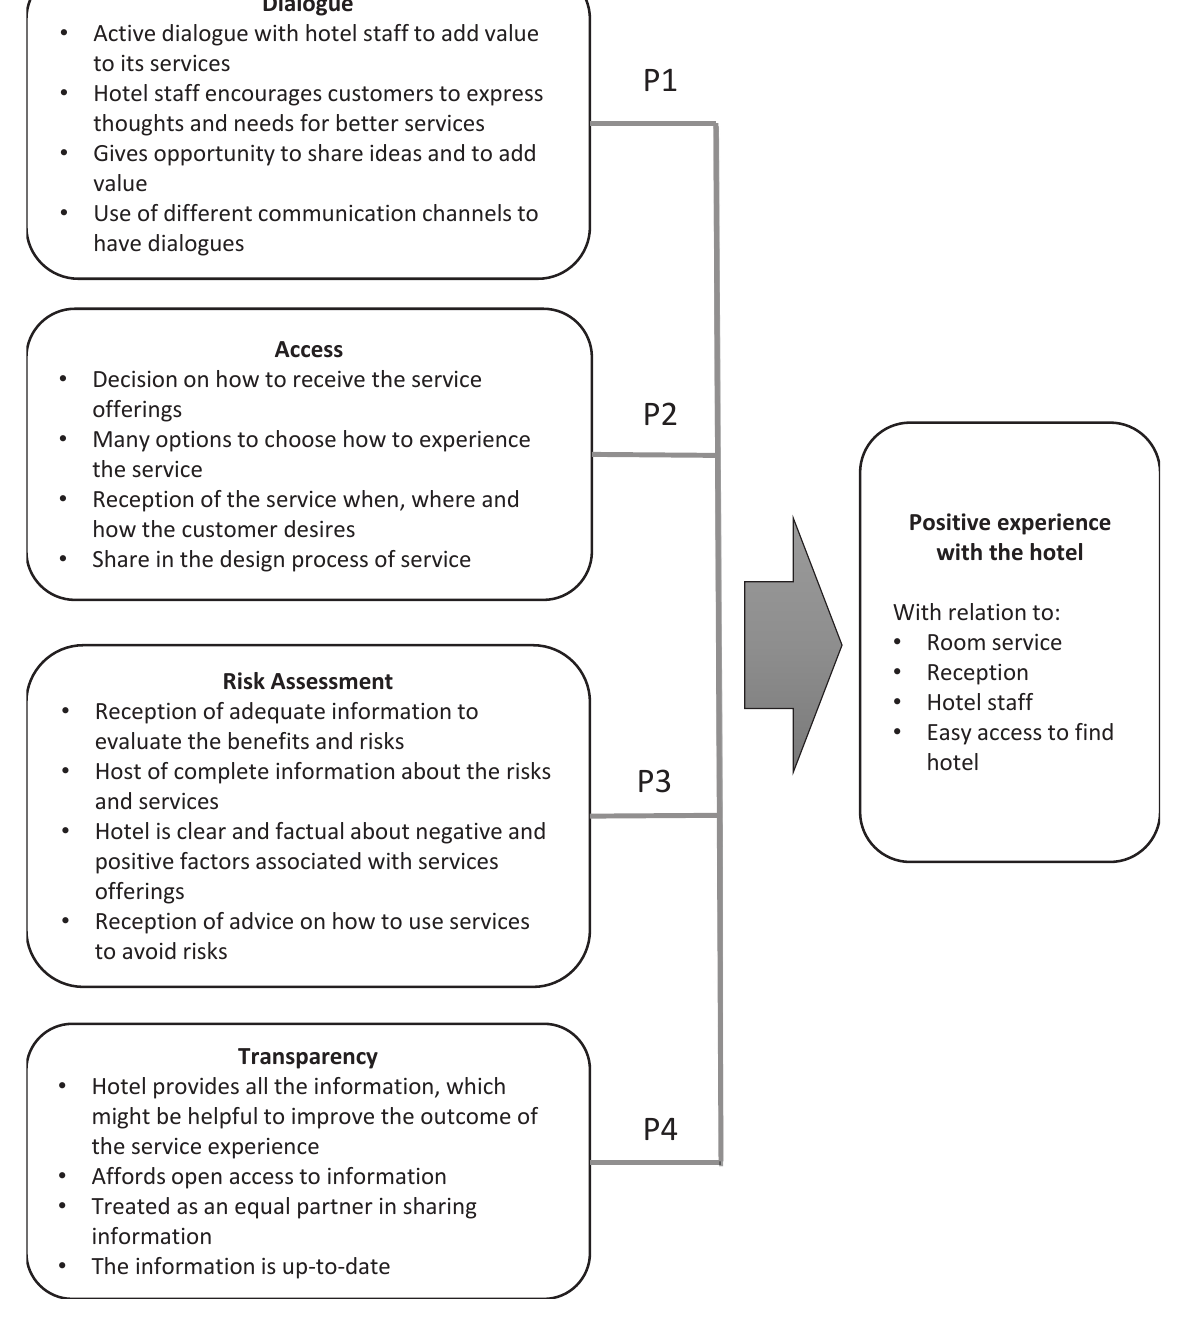
Figure 1. Conceptual framework for